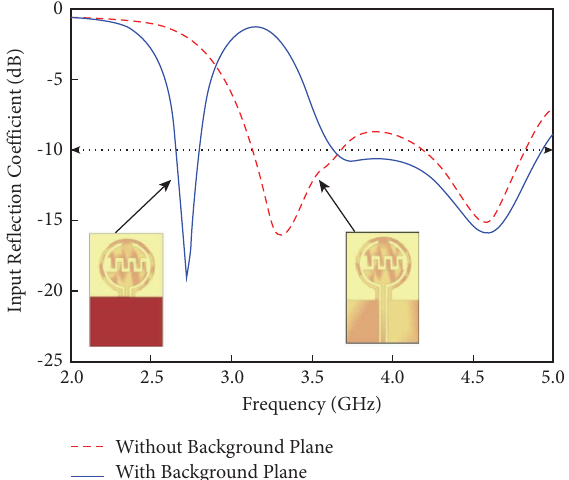
Figure 5: Input refection coefcient of proposed dual-band MTM with and without backed ground plane.